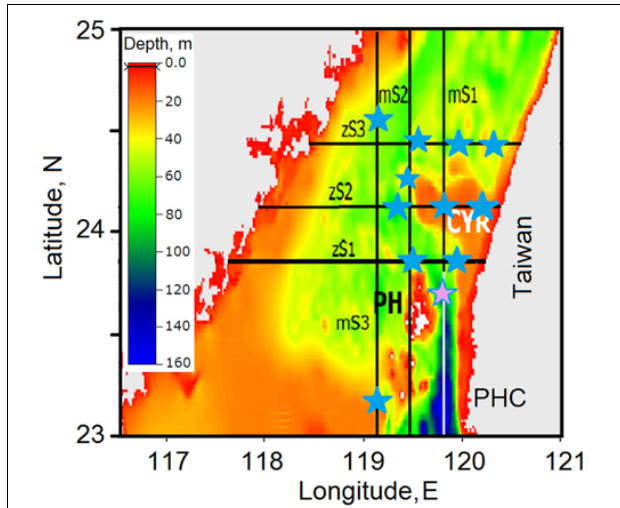
FIGURE 12 | Schematic of locations of potential sites predicted for tidal energy conversion in the Taiwan Strait. Stars denote the sites with a high power density (over 100 Wm - 2 ) and low tide